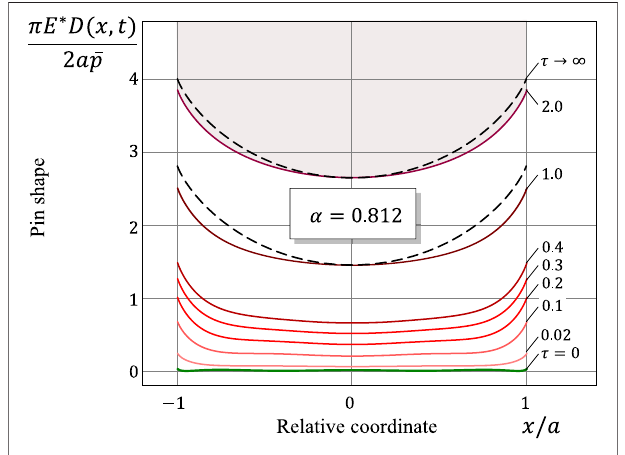
FIGURE 14 | Time-variation of the contact pressure at the center of the contact zone for different values of the parameter α ranging from 0.1 to 0.9 with an increment of